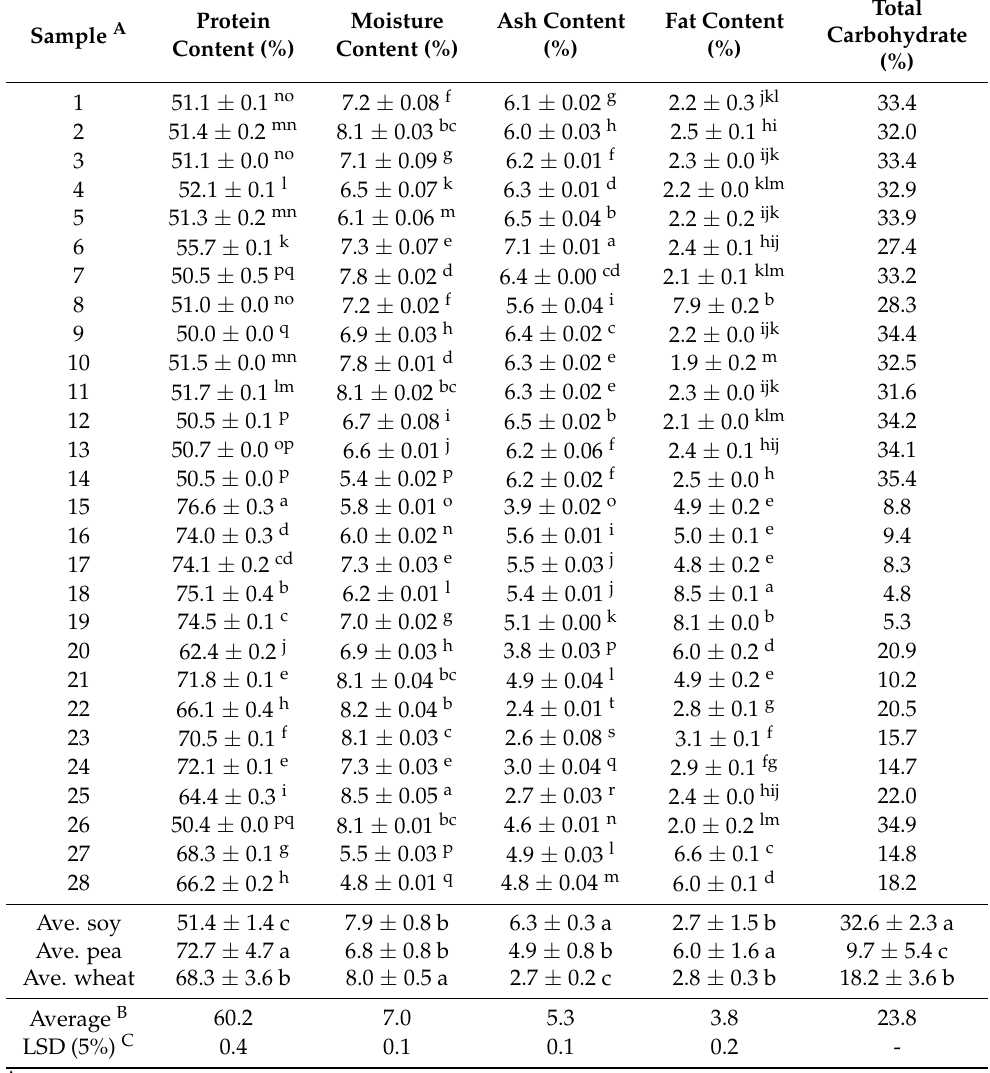
A Protein types of samples: 1–14 (soy protein), 15–21 (pea protein), 22–25 (wheat gluten), 26 (chickpea protein), 27 (pea and chickpea protein mixture), 28 (pea and navy bean protein mixture). Means with different superscript letters within the same column are significantly different ( p < 0.05) among samples 1–28. Different lowercase letters indicate significant difference among means of soy, pea and wheat gluten samples within the same column ( p < 0.05). B,C Average values of all samples and least significant difference (LSD) for comparison of different